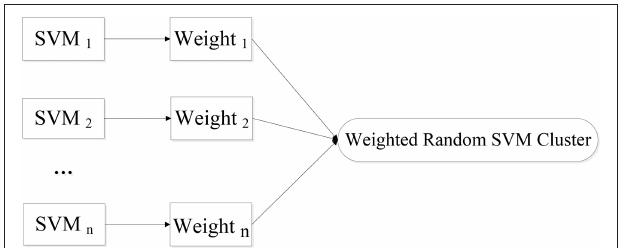
FIGURE 1 | The idea of WRSVMC.